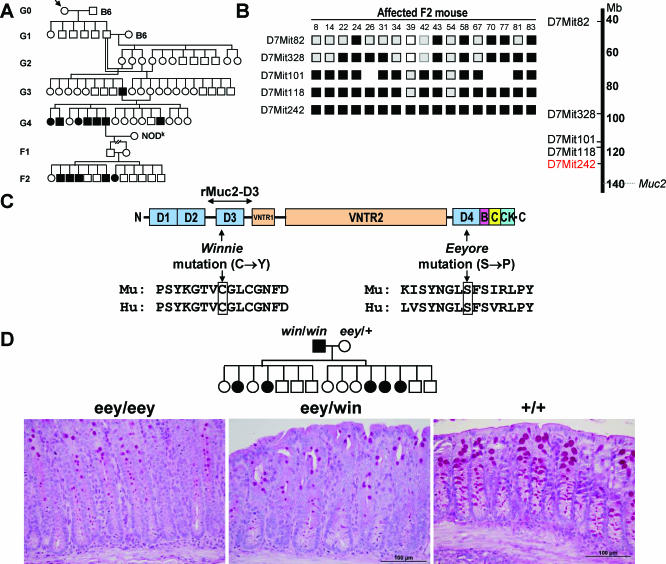
Generation and Characterization of Mice with Muc2 Mutations(A) Dendrogram showing genesis of the Winnie mutation; filled symbols indicate the diarrhoea phenotype.(B) Microsatellite genotype on Chromosome 7 of 17 affected Winnie F2 mice.(C) Domain organization of the Muc2 protein showing the N- and C-terminal vWF D-domains (D1–D4), the C-terminal B, C, and CK domains, and the two central glycosylated tandem repeat domains (VNTR). The sites of the Winnie and Eeyore mutations are shown, together with the region cloned to express the rMuc2-D3 recombinant protein.(D) Results of complementation cross of Win/Win and Eey/+. PAS-stained sections of representative distal large intestinal histological phenotypes demonstrate noncomplementation (preservation of the eey/eey histological phenotype in eey/win).